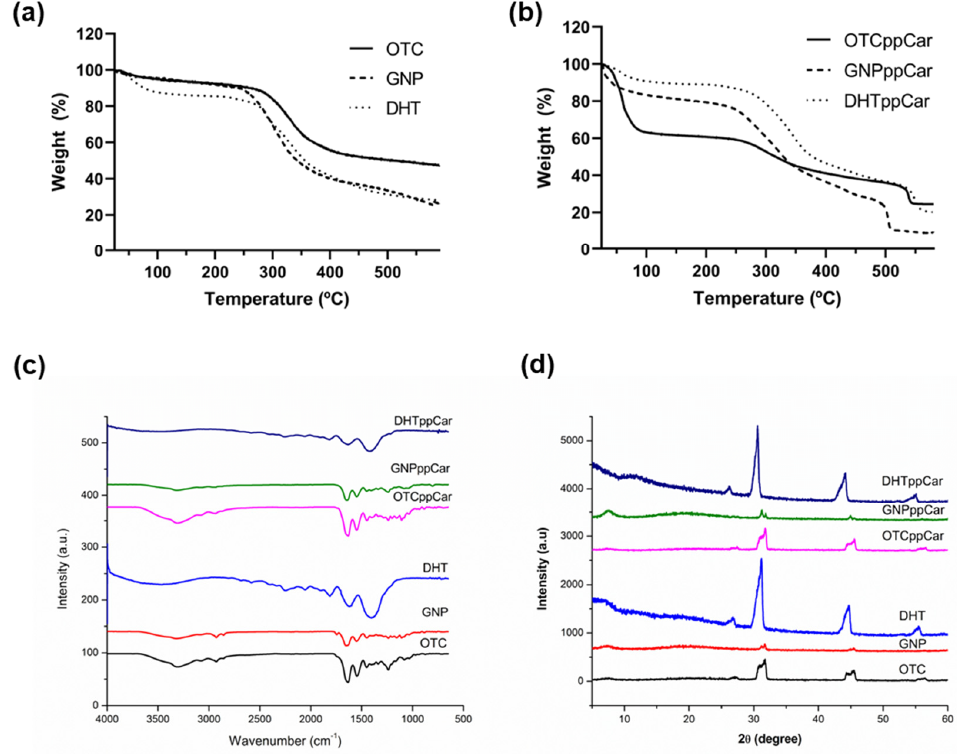
Figure 7. ( a ) TGA analysis of crosslinked OTC-I scaffolds before plasma polymerisation; ( b ) TGA analysis of crosslinked OTC-I scaffolds after ppCar; ( c ) FTIR results of OTC-I biomatrices; ( d ) XRD.